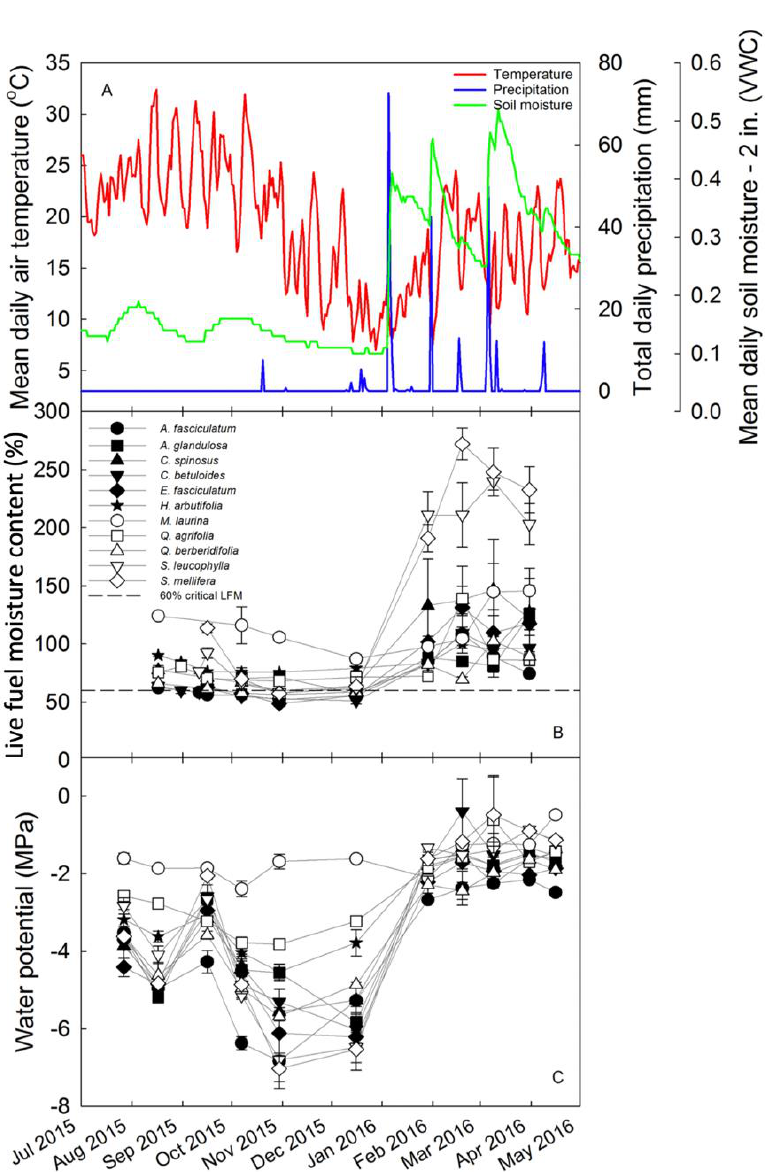
Figure 2. ( A ) Weather data for July 2015 to May 2016, including mean daily air temperature (red line), total daily precipitation (blue line), and mean daily soil moisture (green line), measured from the Stunt Ranch Santa Monica Mountains Research Reserve weather station. ( B ) Live fuel moisture content including the 60% critical threshold used by Los Angeles County Fire Department and ( C ) midday water potential measured for 11 species at Stunt Ranch.